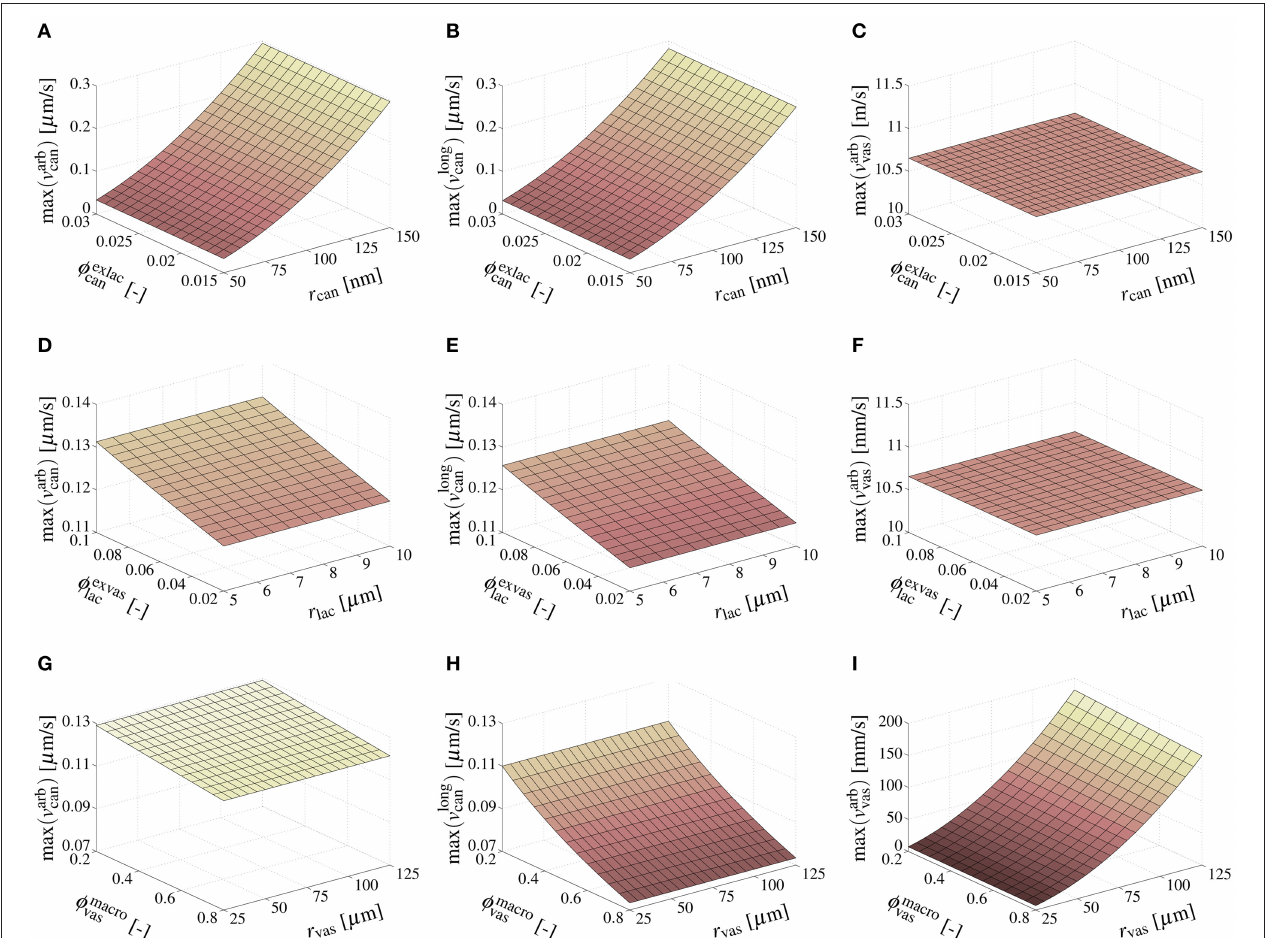
FIGURE 4 | Sensitivities of model-predicted maximum canalicular and vascular pore fluid velocities, in response to the macroscopic pressure gradient grad p macro [0,0,1] T kPa/mm, considering the following variations of porosities and pore radii: φ exlac can = φ exvas lac [0.01,0.1] and r lac [5,10] 10 − 6 m, see (D–F) ; φ macro vas = = ×